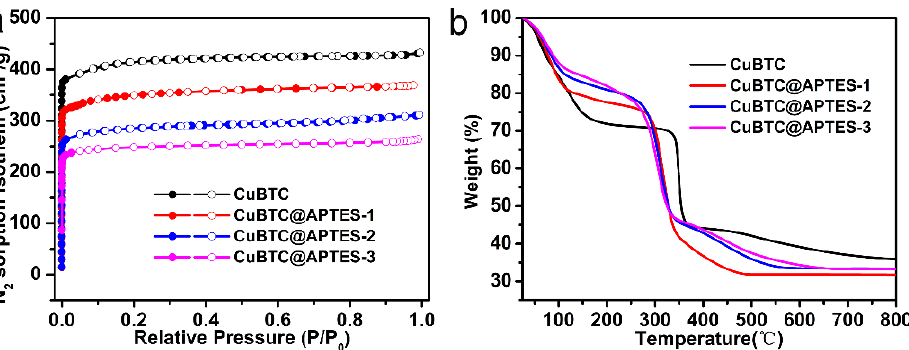
Figure 2. ( a ) FT-IR spectra of CuBTC, APTES and CuBTC@APTES; ( b ) 1 H NMR spectra of the reac- tion solution of CuBTC@APTES; ( c ) XPS spectra of CuBTC and CuBTC@APTES; ( d ) high-resolution XPS spectra for Cu2p in CuBTC and CuBTC@APTES.